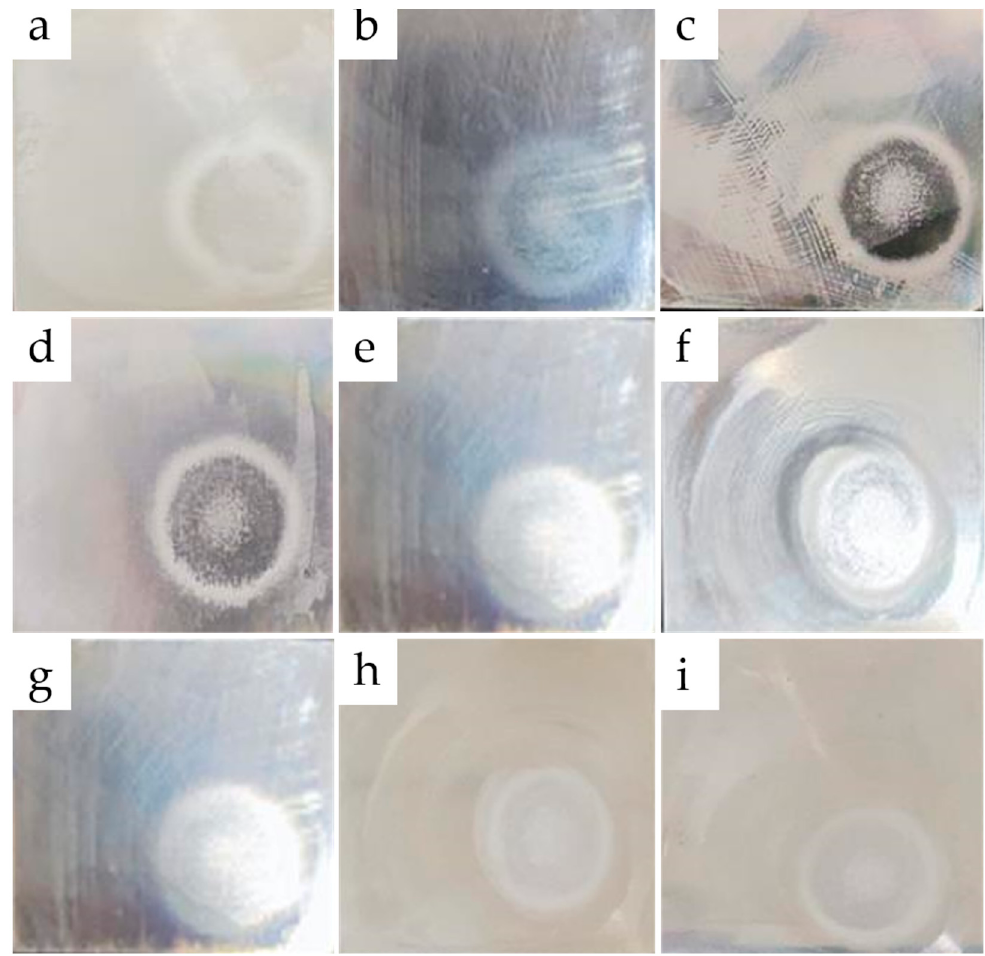
Figure 4. The workpiece surfaces in abrasive suspensions with different SiC contents. ( a ) Abrasive suspension with SiC content of 0; ( b ) Abrasive suspension with SiC content of 2.5 wt.%; ( c ) Abrasive suspension with SiC content of 5 wt.%; ( d ) Abrasive suspension with SiC content of 7.5 wt.%; ( e ) Abrasive suspension with SiC content of 10 wt.%; ( f ) Abrasive suspension with SiC content of 12.5 wt.%; ( g ) Abrasive suspension with SiC content of 15 wt.%; ( h ) Abrasive suspension with SiC content of 17.5 wt.%; ( i ) Abrasive suspension with SiC content of 20 wt.%.